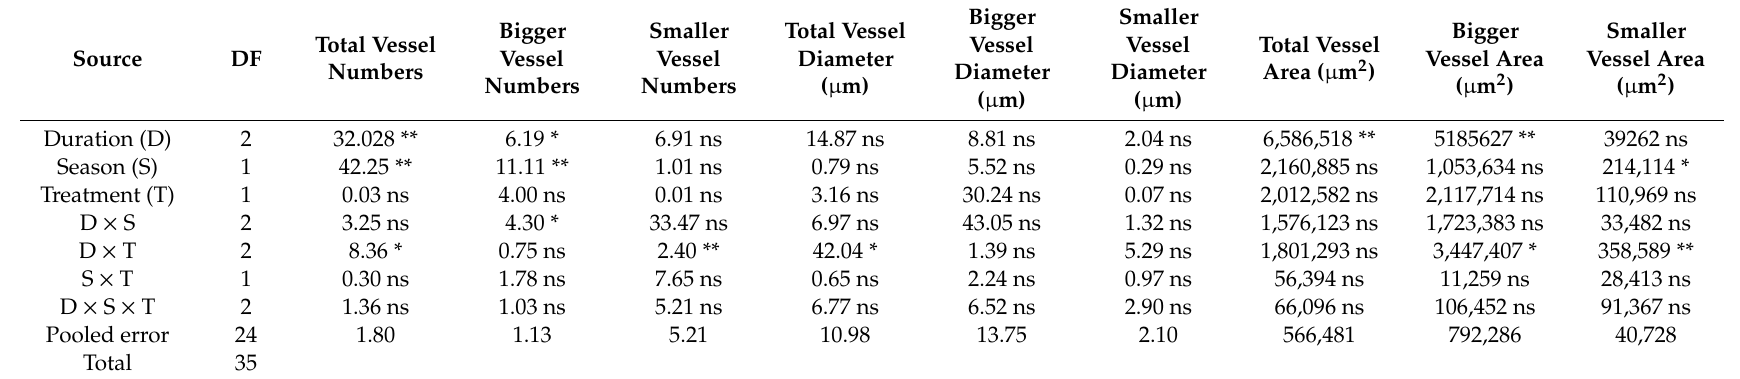
Table 1. Mean square from the combined analysis of variance for total vessel numbers, bigger vessel numbers, smaller vessel number, total vessel diameter ( µ